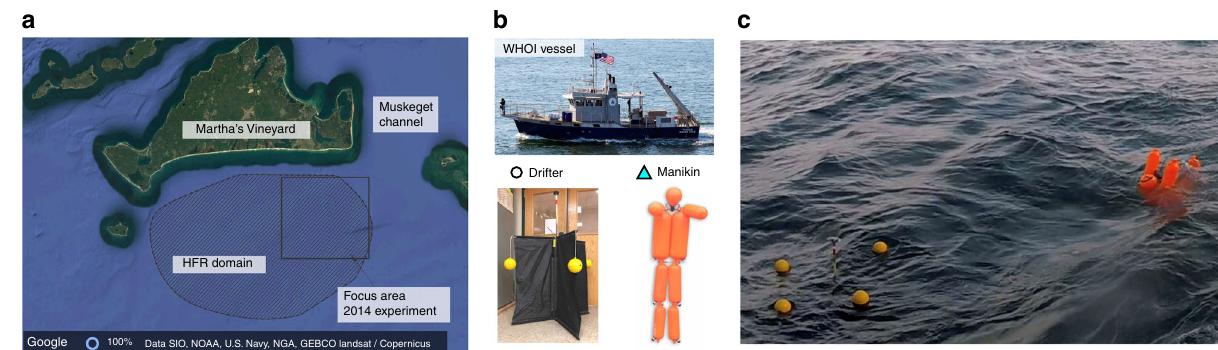
Fig. 3 Field experiments tools and area of interest. a The domain of the ocean fi eld experiments is located south of Martha's Vineyard, where the ocean surface sub-mesoscale velocity, remotely sensed from high-frequency-radar (HFR) measurements as described in ref. 11 , is available within the hatched black polygon. The black rectangle represents the area of interest of the 2014 fi eld experiment. b Tioga WHOI vessel, CODE surface drifter, whose GPS- tracked position will be marked with a white dot, and OSCAR Water Rescue Training manikins whose GPS-tracked position will be marked with a magenta triangle. c Photo illustrating a drifter and a manikin in water during the 2018 experiment. A drone-based video of the 2018 fi eld experiment is available here 17 .